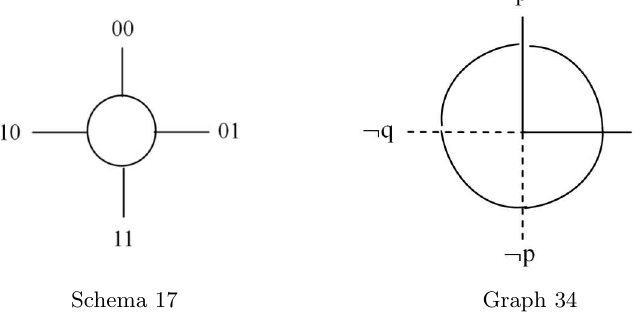
Schema 17 stands for a two-place basic formula: ⌊ p q ⌋ (pq). Graph 34 stands for an assertion: ⊢ p ∨¬ p, or ⊢ q ∨¬ q. Both schema 17 and graph 34 stand respectively for a tautology, i.e., the whole expression is eternally true whether ‘p’ or ‘q’ is true or not.